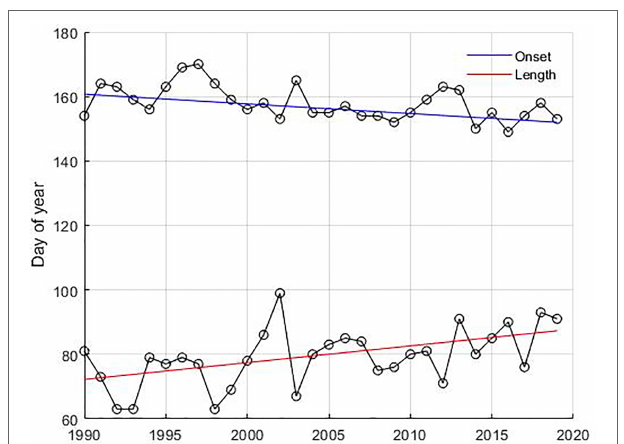
FIGURE 7 | Temporal change in the phenological dates of cyanobacteria blooms. The circles connected with a black solid line represent onset dates and length of the bloom, respectively. The slope of the curve for the onset dates (blue line) and length ofthe bloom (red line) was estimated using the Mann-Kendall test with the non-parametric Sen method using 95% significance